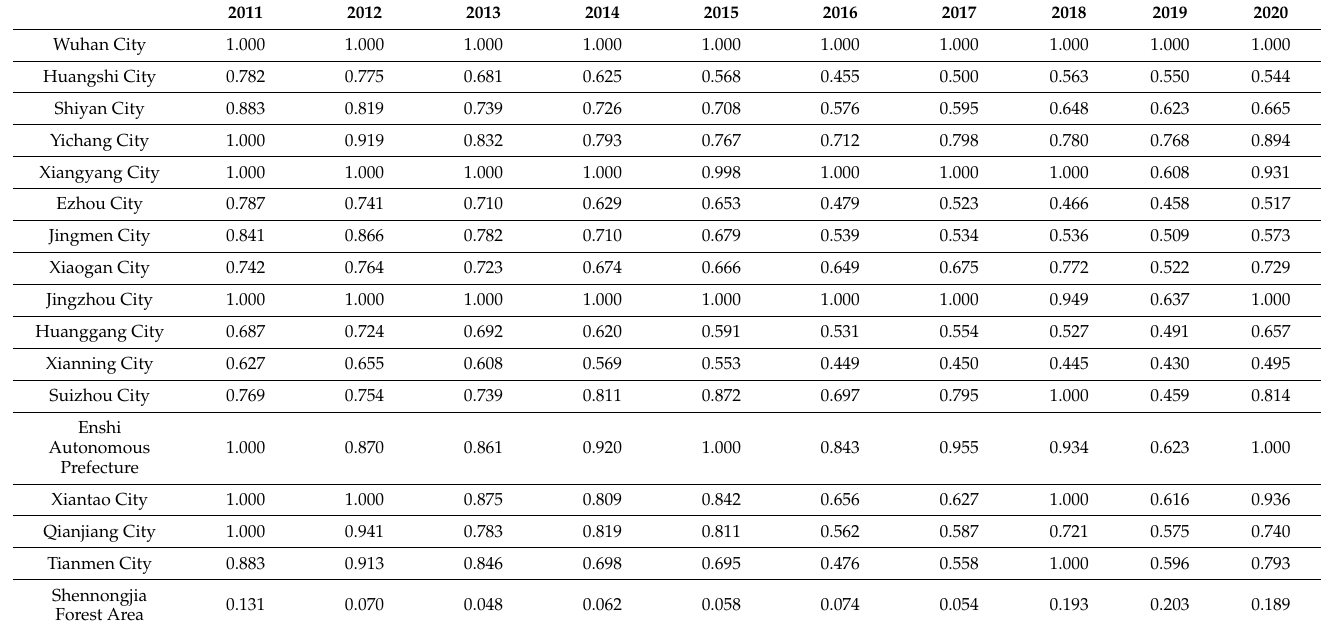
Table 1. Comprehensive water use Efficiency coefficient of prefecture-level cities in Hubei Province from 2011 to